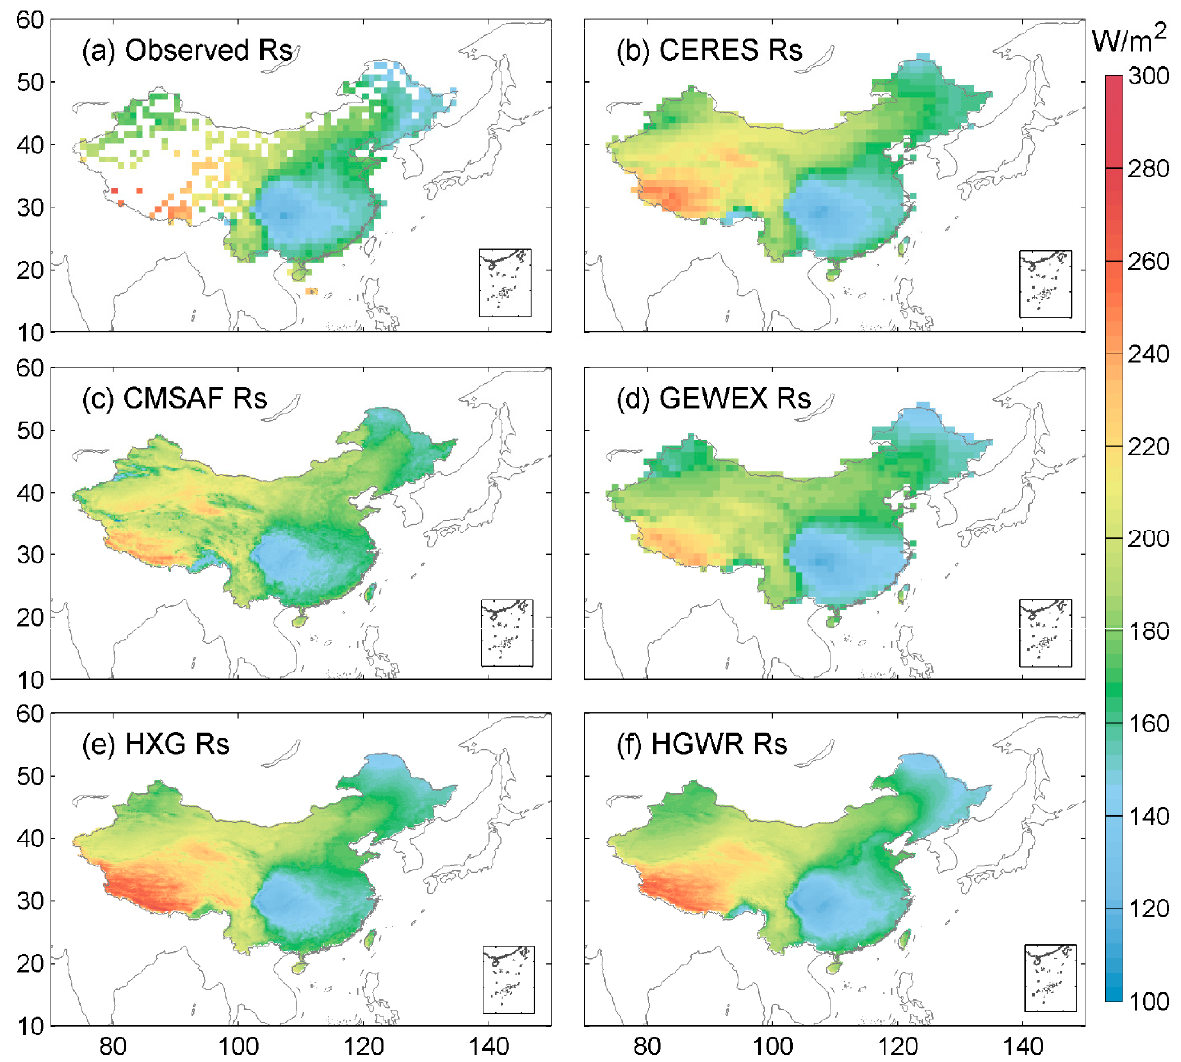
Figure 3. Spatial distribution of multiyear mean R s from 2000 to 2007. The first line ( a , b ) shows the observed multiyear mean R s from SunDu and CERES EBAF (CERES); the multiyear mean R s derived from the CMSAF CLARA-A2 (CMSAF) and GEWEX-SRB (GEWEX) are shown in the second line ( c , d ), respectively. The third line ( e , f ) shows the observed multiyear mean monthly R s from ISCCP-HXG (HXG) and ISCCP-HXG merged with SunDu-derived R s (HGWR).